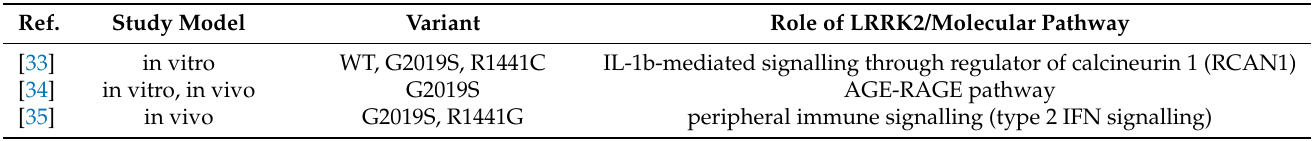
Table 3. Studies exploring the role of LRRK2 in neuroinflammatory pathways. Ref.